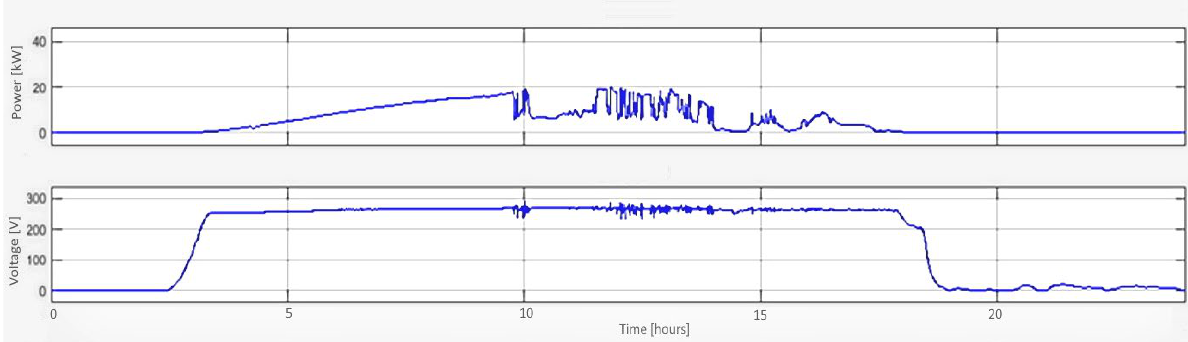
Figure 18. Daily waveform of power generated by the modules and the average voltage at the output of the PV modules (19.825 kW) on a sample day in July.